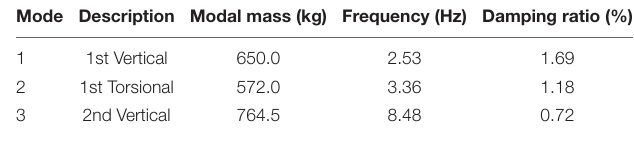
TABLE 3 | Dynamic properties of the first three vibration modes of a laboratory FRP footbridge (Russell et al.,